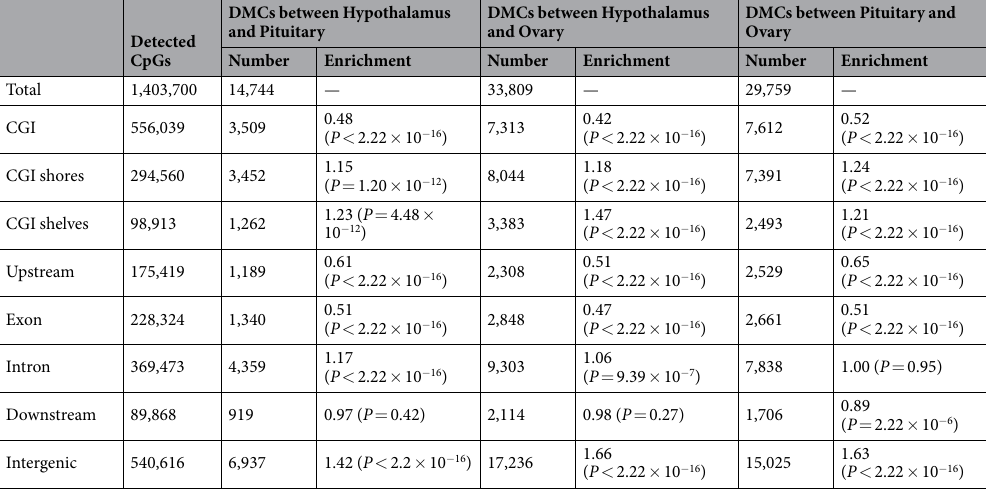
Table 2. Distribution of differentially methylated CpGs among HPO methylomes. The enrichment of DMCs for certain genomic regions was using with a two-tail Fisher’s exact